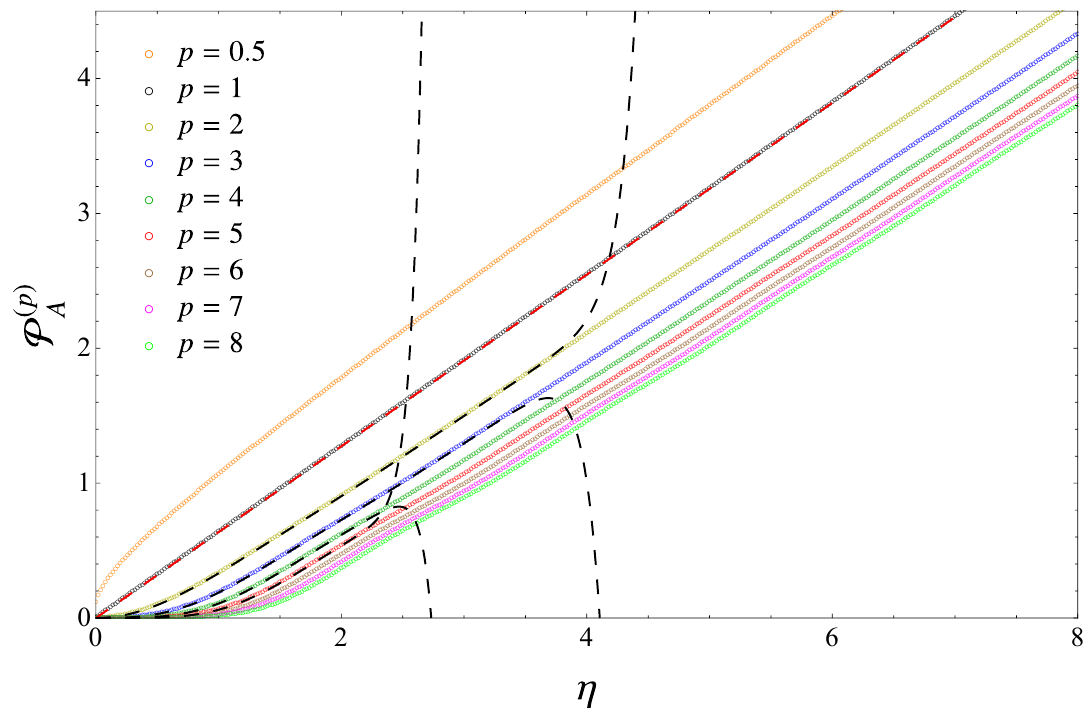
Figure 13. The p -th power of the Schatten p -norm of the sine kernel operator (see (9.1)) for some values of p > 0 , in the regime of small η . When p = 1 , the exact result is given by (3.7) for every η . The dashed red line corresponds to (3.7) (see also (9.9)) and the dashed black lines to